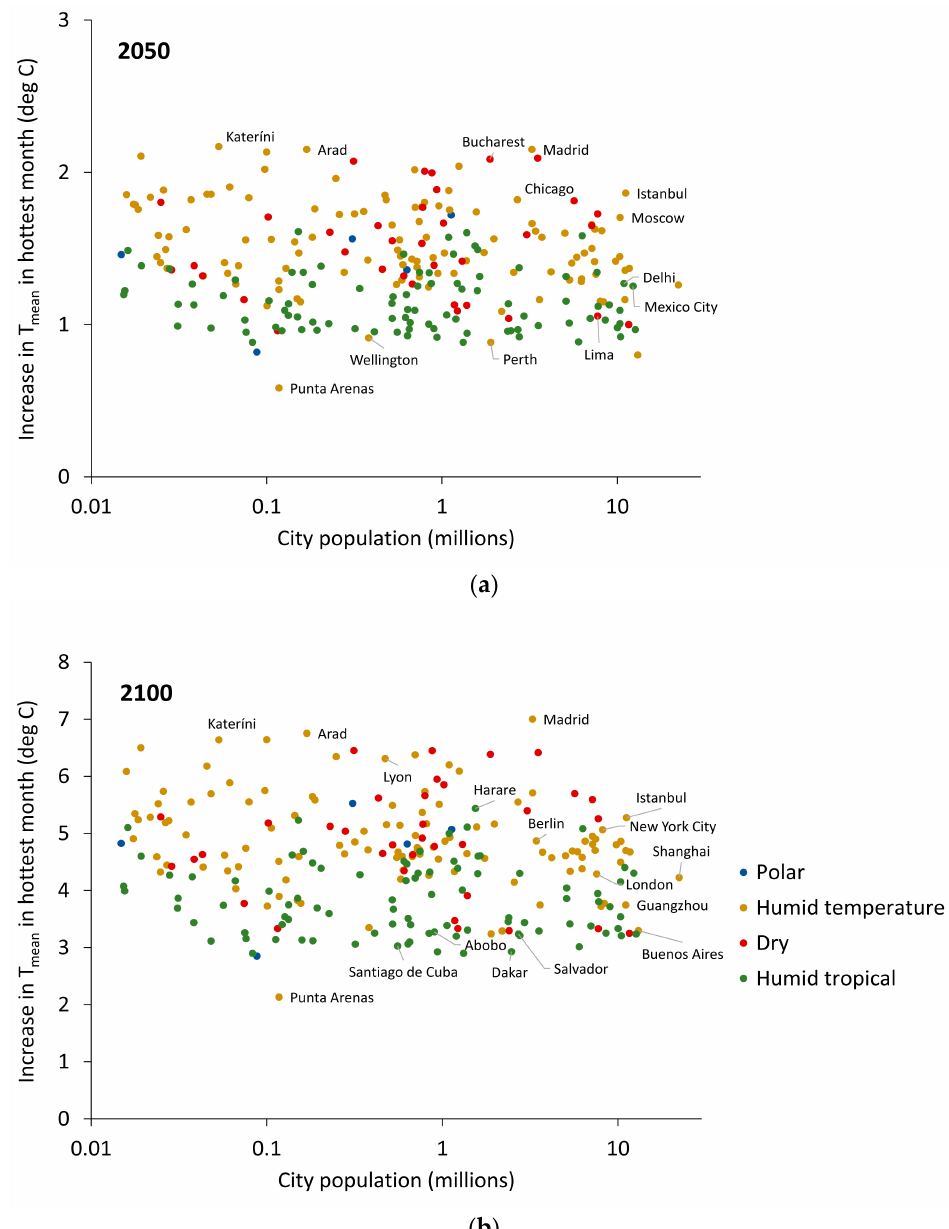
Figure 6. Increase in T mean in the hottest month by 2100 (relative to 2017) under RCP8.5 vs. city population size (log scale) by ( a ) the year 2050 and ( b ) the year 2100. Colouring indicates Bailey’s ecoregion domain.